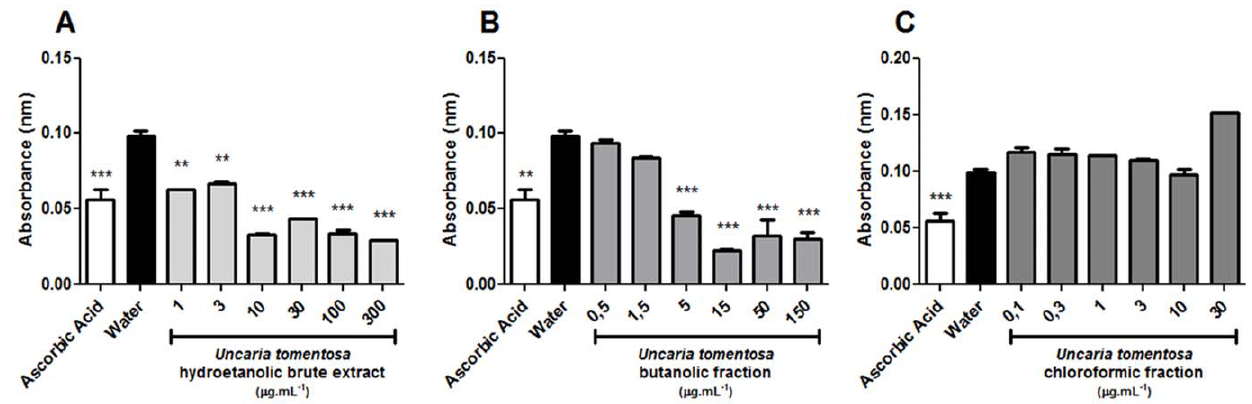
Figure 3. Assessment of the free radical-scavenging activity of the BHE extract of U.tomentosa (A), as well as its two resulting fractions: BuOH (B) and CHCl 3 (C) at various concentrations. Negative control was distilled water and positive control was ascorbic acid (50 m g.mL 2 1 ). Symbols: ** p , 0.01 and *** p , 0.001 as compared to the negative control.